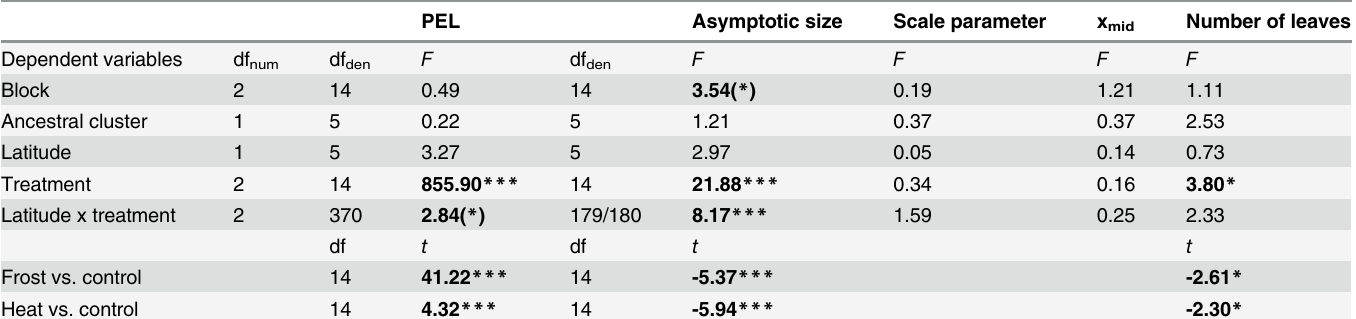
Table 1. Results of hierarchical mixed model analysis testing the effect of block, ancestral cluster, latitude, treatment and the interaction between the latter two on percentage electrolyte leakage (PEL), three parameters describing plant growth (asymptotic size, scale parameter and mid-point of growth x mid ), and the number of leaves of Arabidopsis lyrata plants ( N = 384, 194, 193, 193, 194).